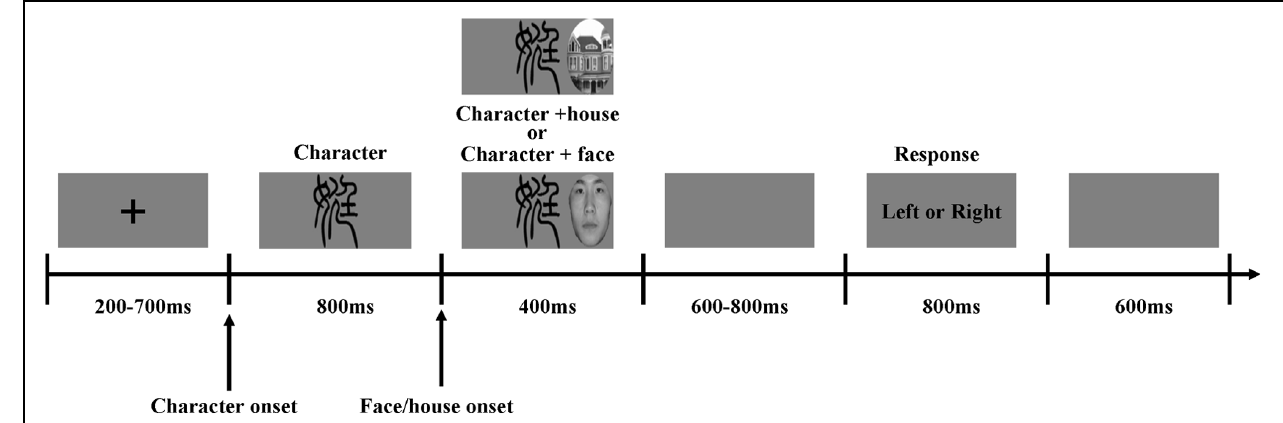
FIGURE 2 | Overview of a representative experimental trial. In the beginning, a fixation point was presented for 200–700 ms. Then, a recognizable or unrecognizable Xiaozhuan typeface character was presented on the center of the screen for 1200 ms. After an-800 ms-character presentation, a face or a house appeared to the left or right of the character for 400 ms. After the two stimuli disappeared concurrently, there was a 600–800 ms gray screen. Participants were then requested to press keys for responding to the lateralized face/house detection task: pressing “1” when faces or houses appeared on the left side of the characters and pressing “2” when faces or houses appeared on the right side of the characters. Finally, a gray screen was presented for 600 ms.